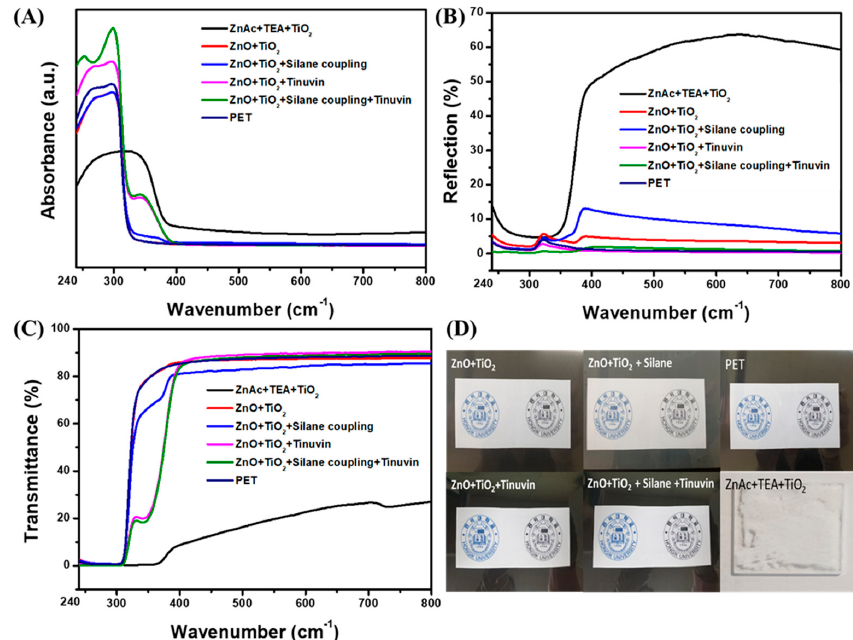
Figure 4. ( A – C ) UV – vis spectra of ZnO – TiO 2 thin films with the different compositions ZnO – TiO 2 – TEA, ZnO – TiO 2 , ZnO – TiO 2 – silane, ZnO – TiO 2 – Tinuvin and ZnO – TiO 2 – silane - T inuvin . ( D ) micros- copy images of the transmittance of each sample .